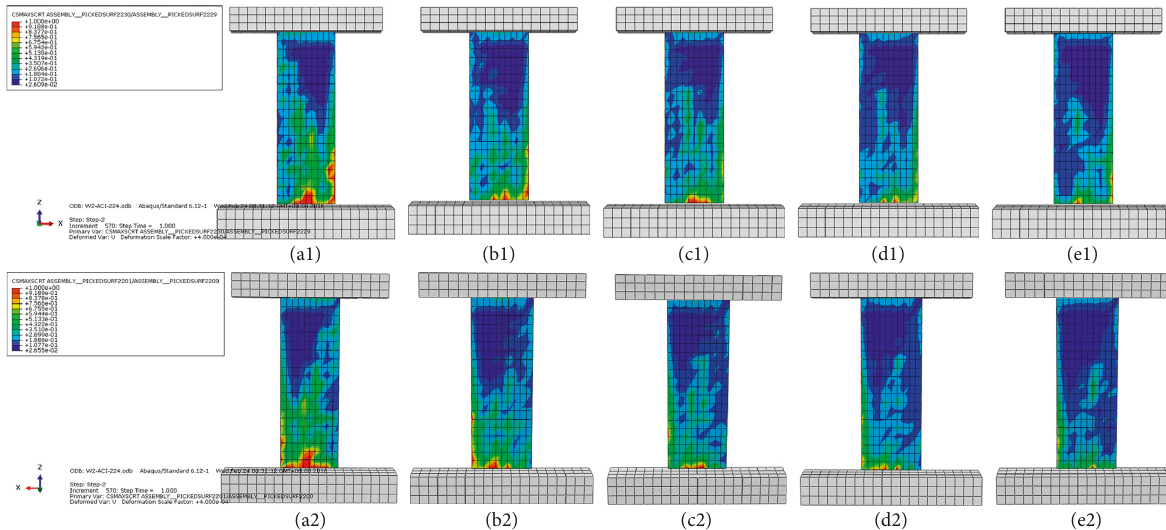
Figure 15: Maximum traction damage initiation criterion index CSMAXSCR of W2.